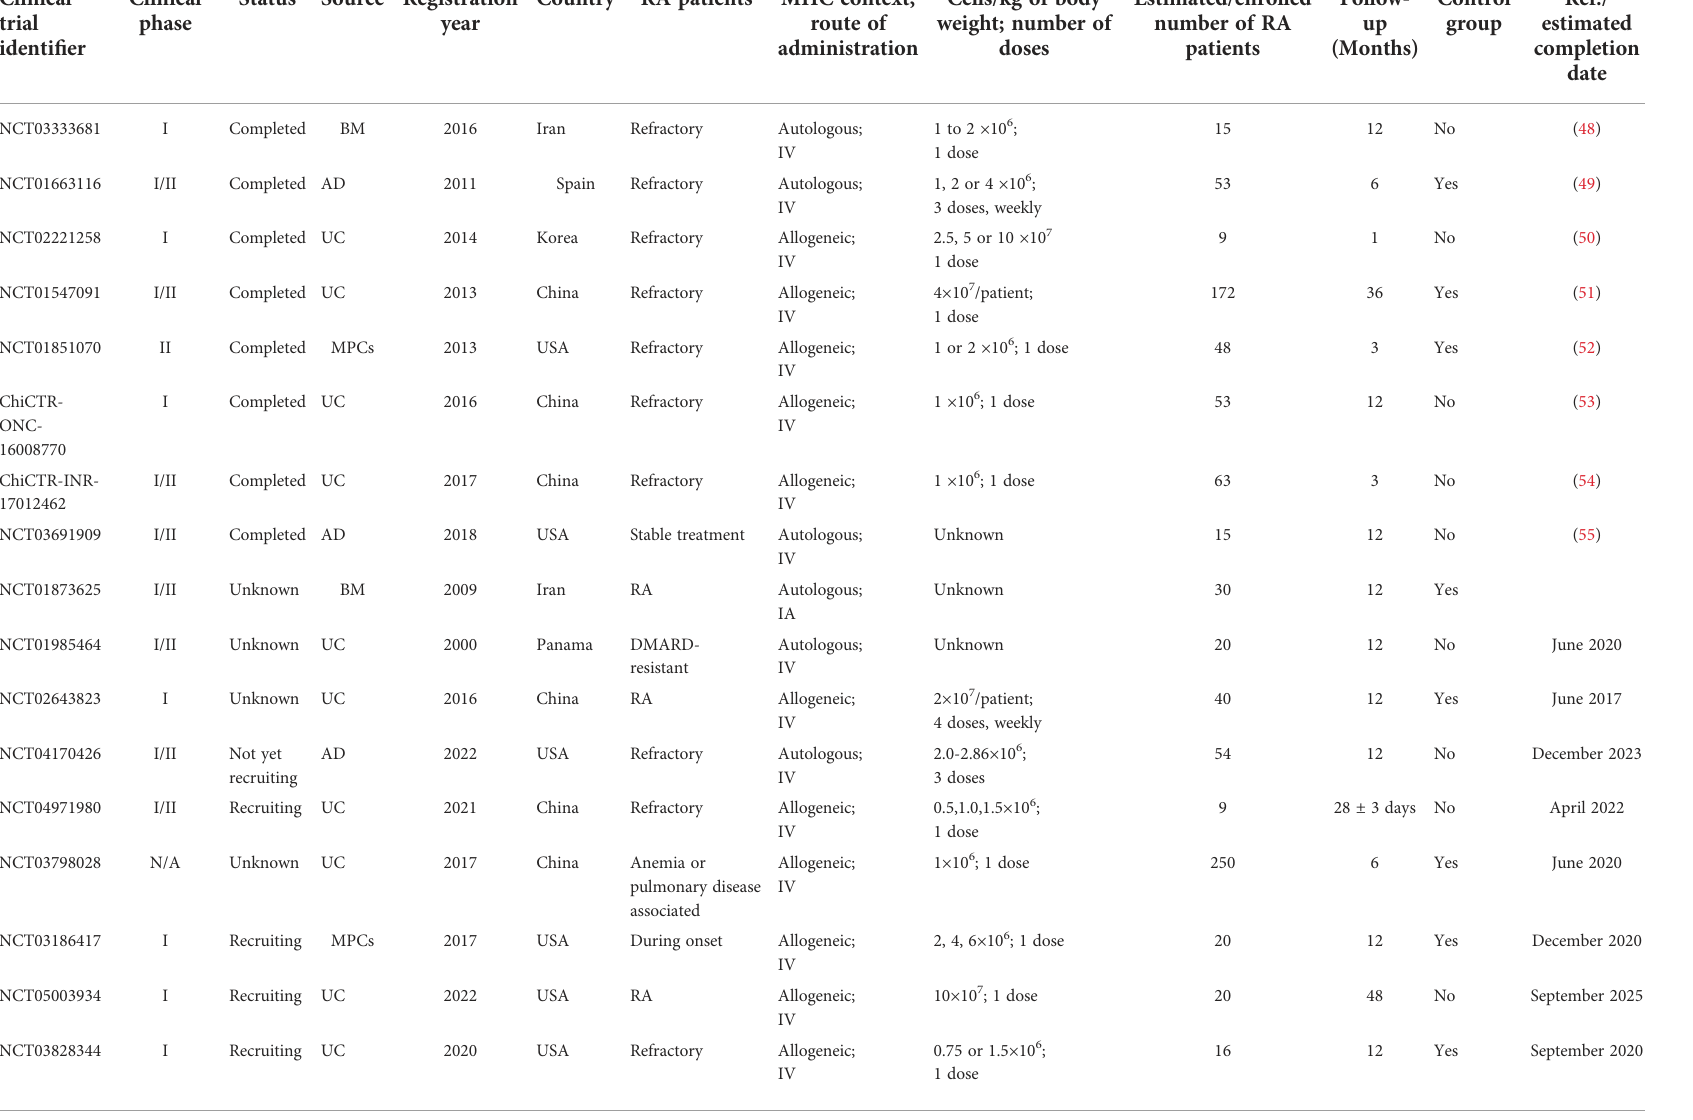
TABLE 2 Summary of Clinical Trials with MSCs in Treating Rheumatoid